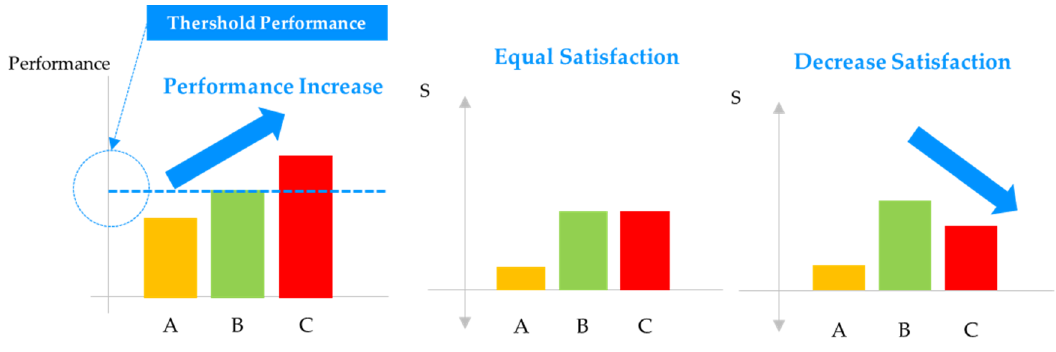
Figure 6. Method for setting up maximum performance target by comparing SI to engineering